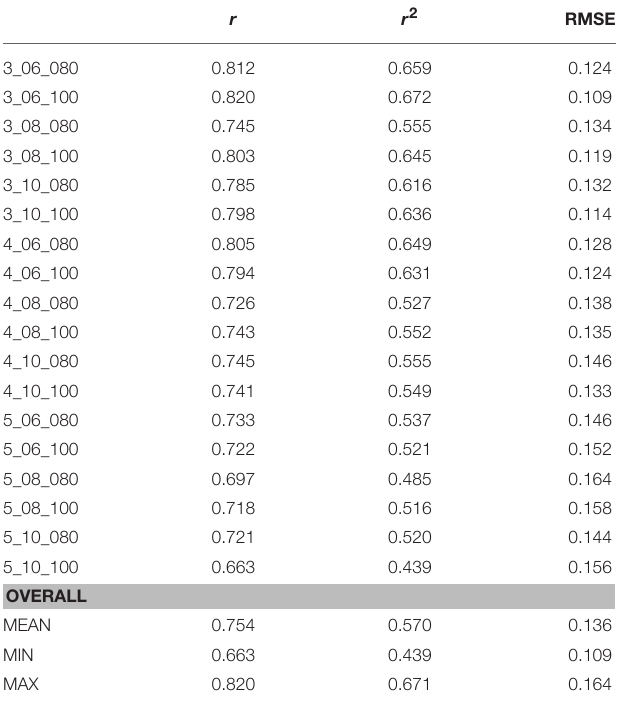
TABLE 3 | Values of r , r 2 , and RMSE of the 18 versions of the